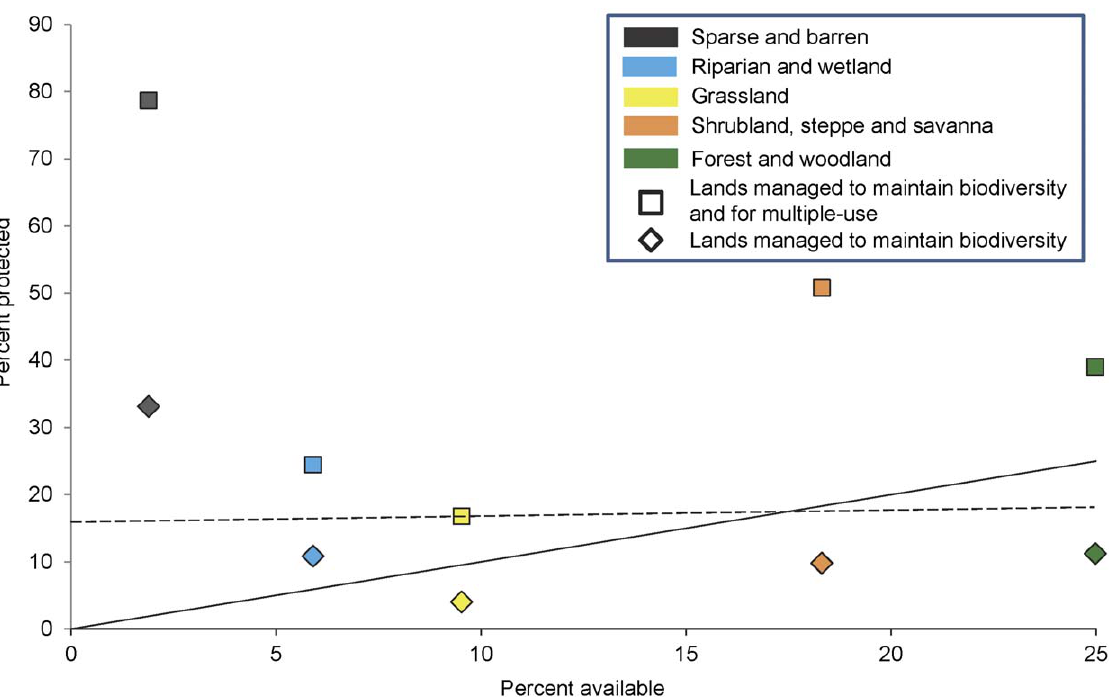
Figure 2. Percent protected and available for each Level I land cover group by protection status. Lands managed to maintain biodiversity (diamonds) are shown relative to lands managed to maintain biodiversity and for multiple-use (squares). See Table 1 for protection status descriptions. A comparison index line is shown, which indicates a 1:1 relation between percent availability and percent protected [61]. A value below the 1:1 line represents a Level I land cover group under-represented in the protected areas network, a value above represents a Level I land cover group well represented in the protected areas network, while a value on the line indicates a Level I land cover group available and protected equally [61]. For example, grassland, a Level I land cover group, has about 4% of its area managed to maintain biodiversity, but that increased to about 17% when lands managed for multiple-use were included [23,24]. A dashed line representing the 17% Aichi Biodiversity Target of the Convention on Biological Diversity is shown